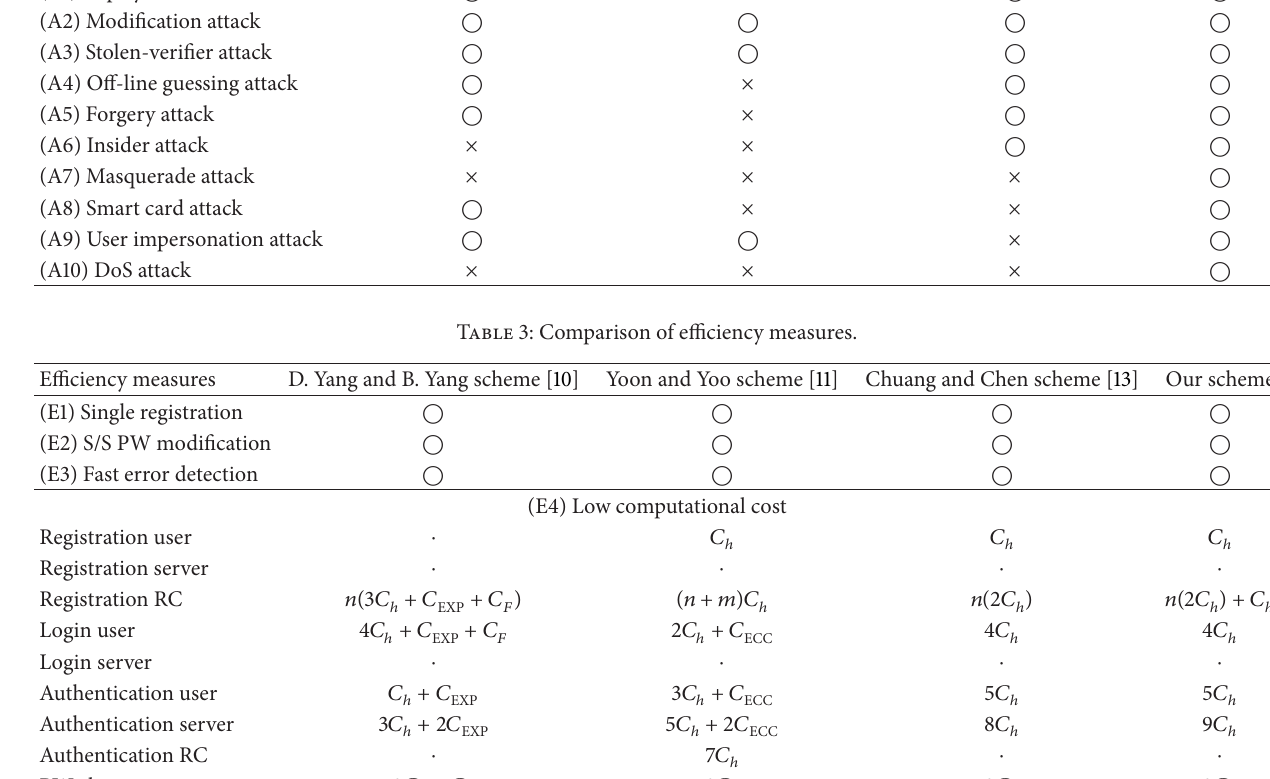
Table 2: Comparison of attack resistance.